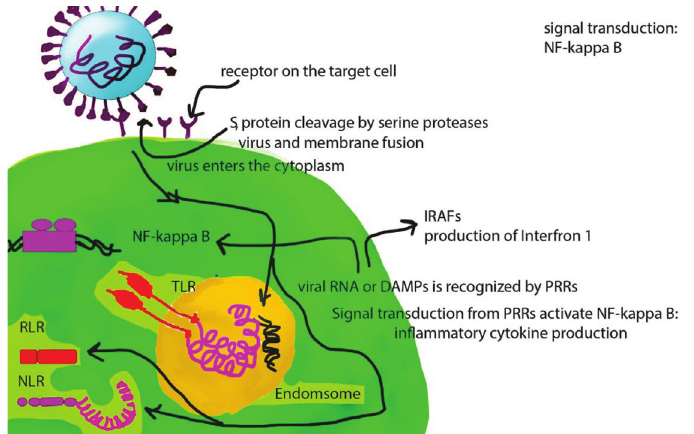
Figure 1. After a pathogen enters the human’s body, it is recognized by RPRs in the innate immune system, and when target cells get infected with the pathogen, damage-associated molecular patterns (DAMPs) are recognized by them. The production of inflammatory cytokines enhances through signaling from these receptors. The genes of these cytokines are expressed following the activation of the NF kappa B pathway. Following activation of the IRF pathway, after TLRs or RLRs recognize the viral RNA, the antiviral response is induced by interferons’ expression. Additionally, macrophages can get directly infected by SARS-CoV-2 as they express ACE 2; NF-kappa B. S protein (spike protein), TLR (toll like receptor),NLR, NOD like receptor, RLR,PRR and